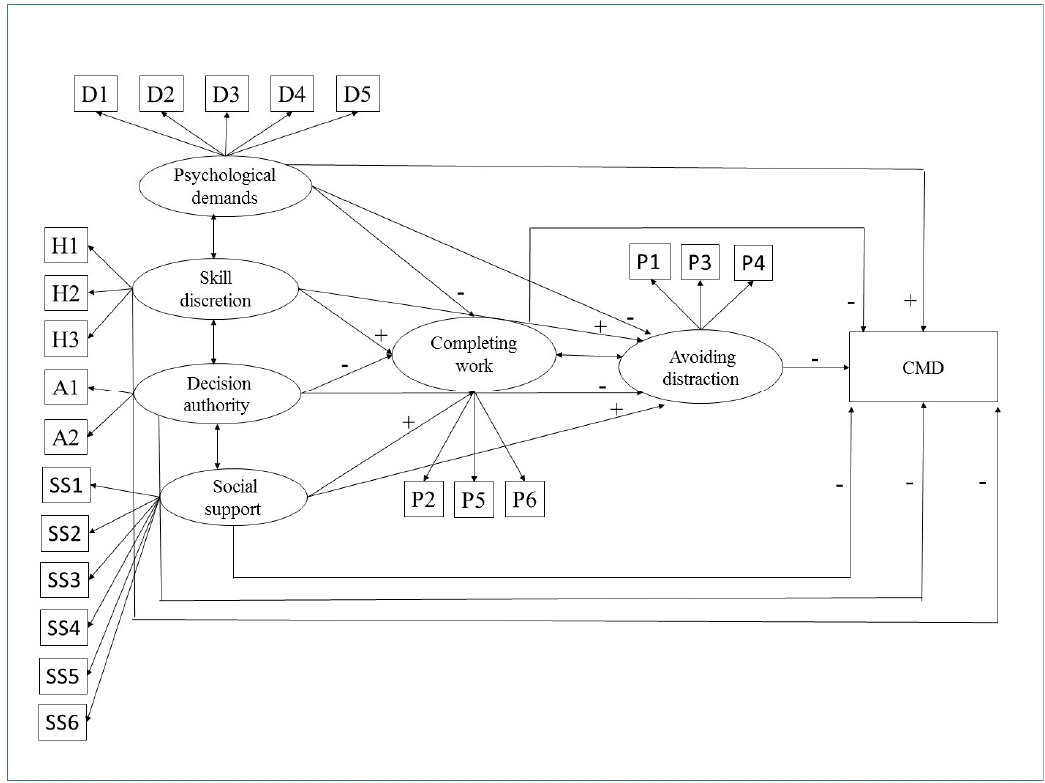
Figure 1. The role of presenteeism (work completed and distraction avoided despite health problem) in the relationship between psychosocial aspects of work and common mental disorders (CMD).